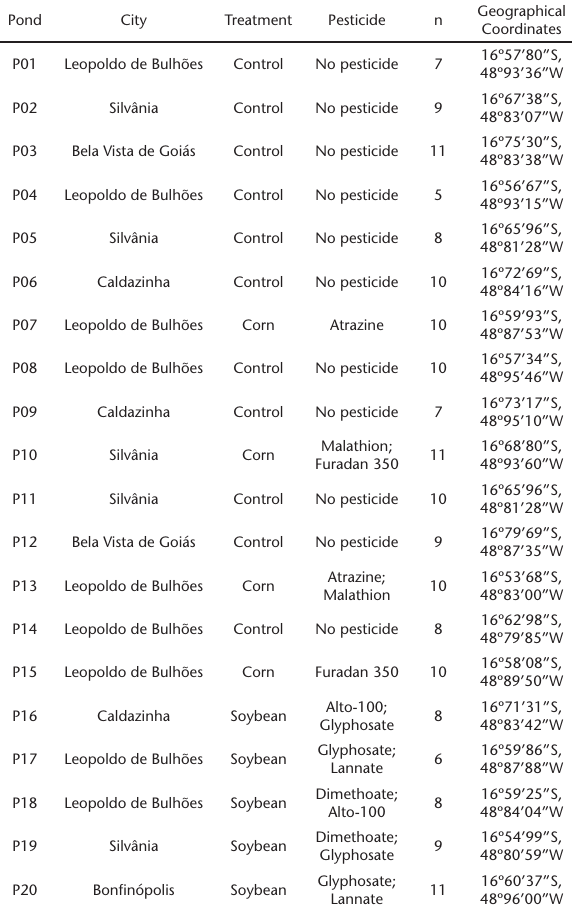
Table 1. Sample areas of the Physalaemus cuvieri tadpoles (pond, city), number of individuals (n) and type of pesticides (related by the farmers), from November/2013 to